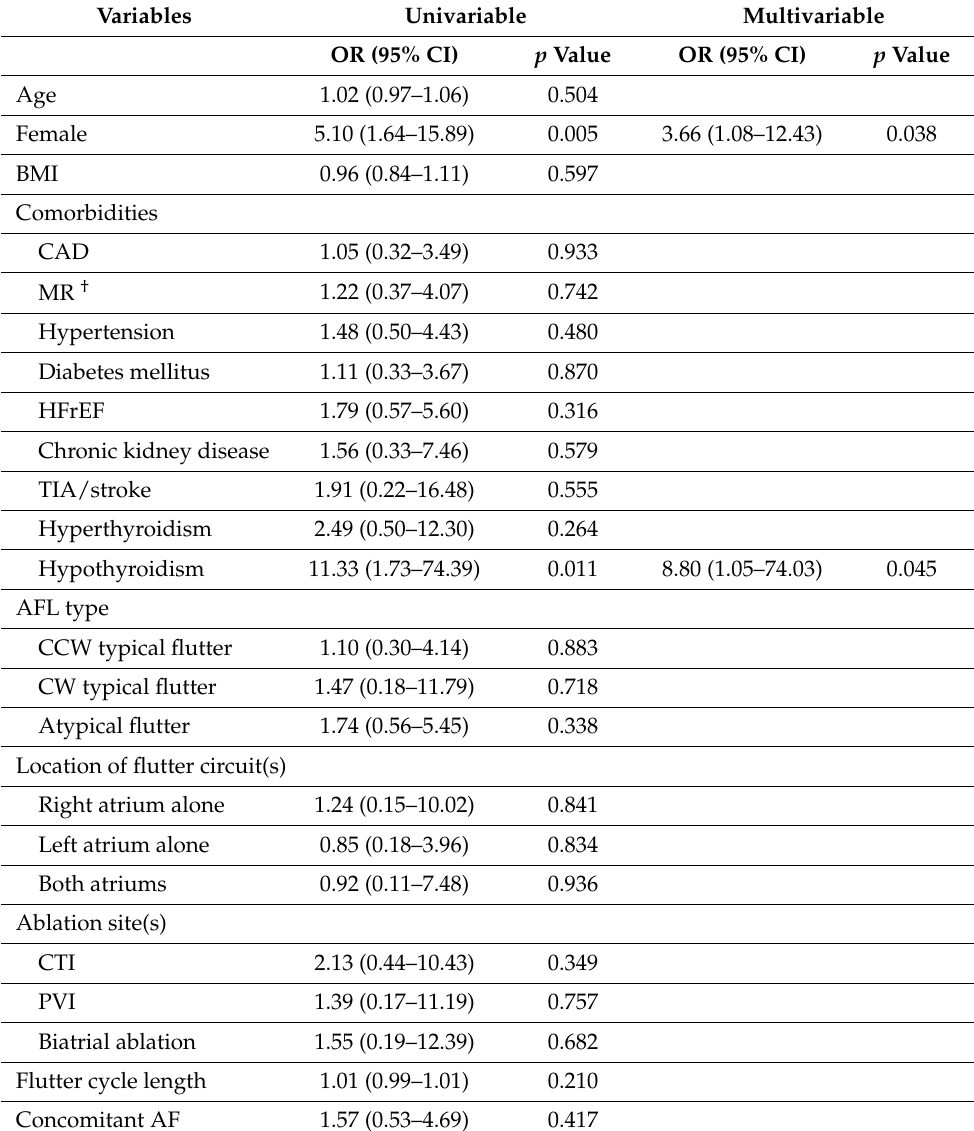
Table 2. Logistic regression analysis of variables to predict acute SND requiring a TPM after AFL termination ( n =